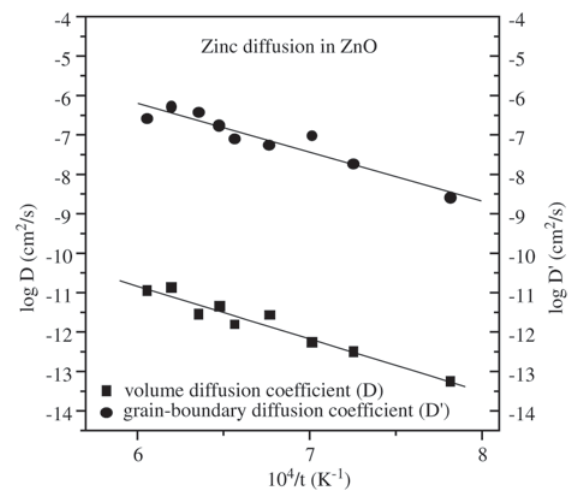
Figure 4. Plot of ln(-dI/dx) vs. x 6/5 , after diffusion at 1300 °C.